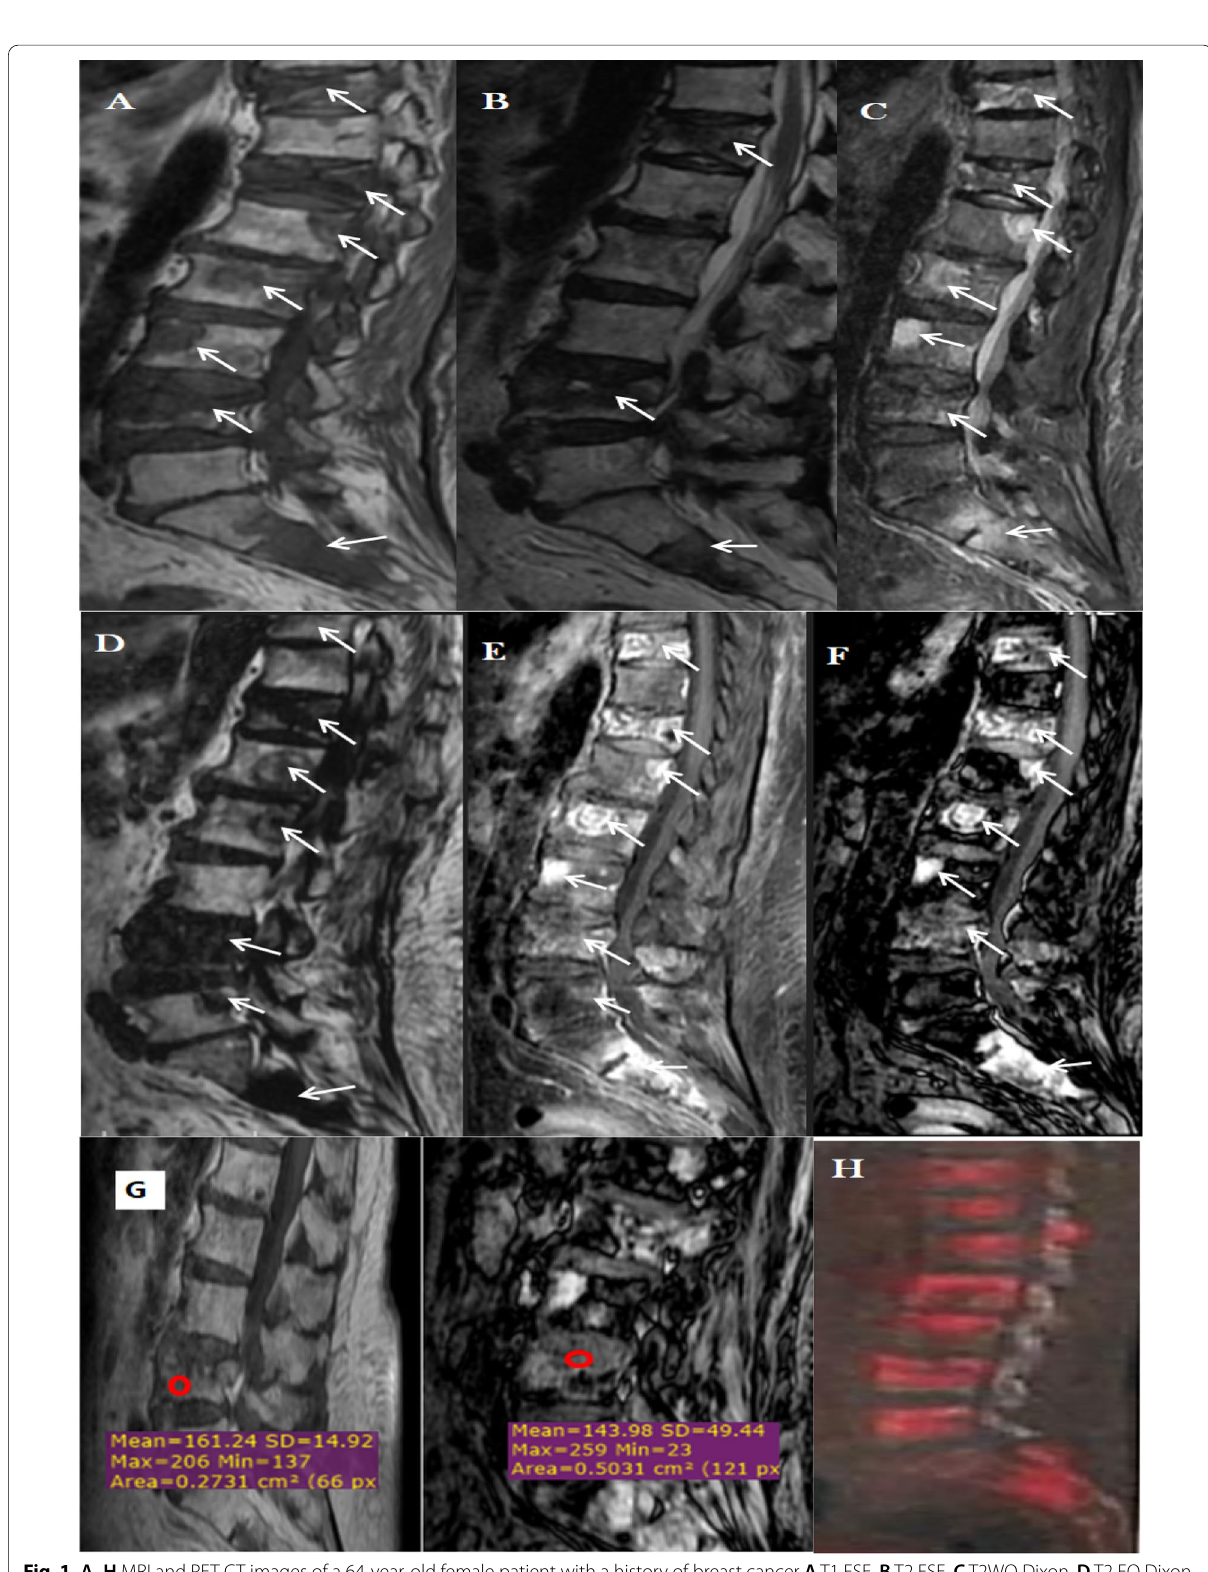
Fig. 1 A – H MRI and PET CT images of a 64-year-old female patient with a history of breast cancer A T1 FSE, B T2 FSE, C T2WO Dixon, D T2 FO Dixon E T1 post-contrast WO Dixon, F T1 post-contrast OP Dixon, G IP/OP ratio MR images and H FDG PET CT show multiple lumbar and sacral vertebral metastasis (white arrows) with IP/OP ratio